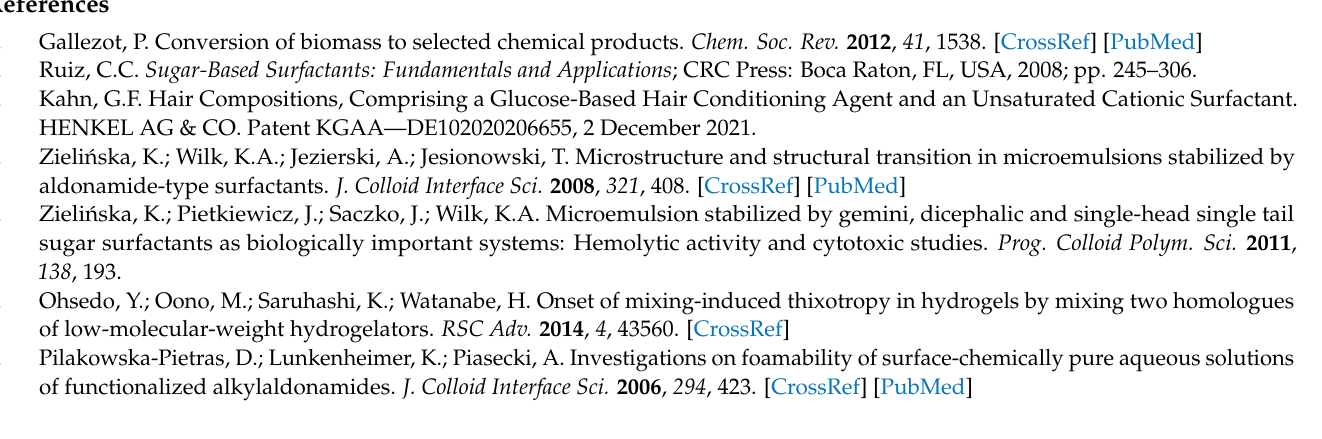
Figure S7: 1 H NMR spectrum of 4b crude; Figure S8: 13 C NMR spectrum of 4b crude; Figure S9: COSY NMR 2D spectrum of 4b crude; Figure S10: HSQC 13 C- 1 H NMR 2D spectrum of 4b crude; Figure S11: HRMS analysis of 4b crude; Figure S12: IR analysis of 4b crude; Figure S13: 1 H NMR spectrum of 4c crude; Figure S14: 13 C spectrum of 4c crude; Figure S15: 1 H NMR spectrum of 4d crude; Figure S16: 13 C NMR spectrum of 4d crude; Figure S17: 1 H NMR spectrum of 4e crude; Figure S18: 13 C NMR spectrum of 4e crude; Figure S19: 1 H NMR spectrum of 4f crude; Figure S20: 13 C NMR spectrum of 4f crude; Figure S21: 1 H NMR spectrum of 4h crude; Figure S22: 13 C NMR spectrum of 4h crude; Figure S23: 1 H NMR spectrum of 4i (cid:48) crude; Figure S24: 13 C NMR spectrum of 4i (cid:48) crude; Figure S25: COSY NMR 2D spectrum of 4i (cid:48) crude; Figure S26: HSQC 13 C- 1 H NMR 2D spectrum of 4i (cid:48) crude; Figure S27: HRMS analysis of 4i (cid:48) crude; Figure S28: IR analysis of 4i (cid:48) crude; Figure S29: 1 H NMR spectrum of 4j crude; Figure S30: 13 C NMR spectrum of 4j crude; Figure S31: COSY NMR 2D spectrum of 4j crude; Figure S32: HSQC 13 C- 1 H NMR 2D spectrum of 4j crude; Figure S33: HRMS analysis of 4j crude; Figure S34: IR analysis of 4j crude; Figure S35: 1 H NMR spectrum of 4k crude; Figure S36: 13 C NMR spectrum of 4k crude; Figure S37: 1 H NMR spectrum of 4l crude; Figure S38: 13 C NMR spectrum of 4l